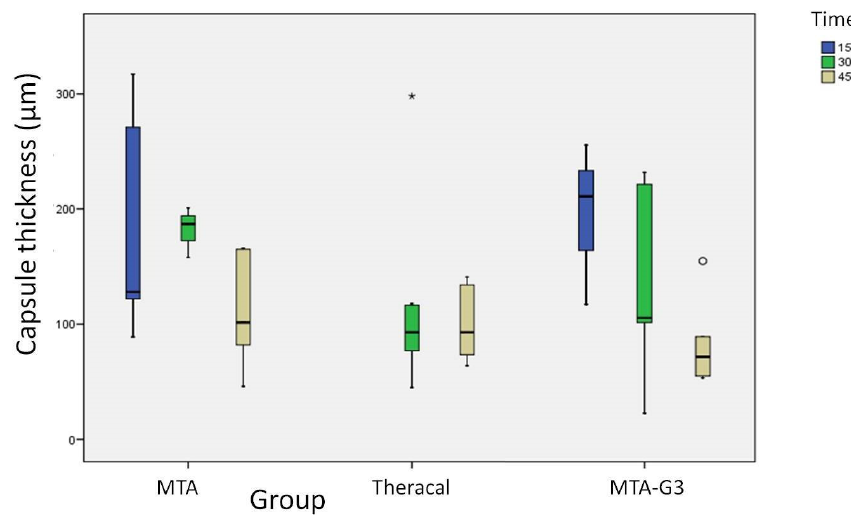
Figure 5. MTA, Theracal and MTA-G3 fibrous capsule thickness. Differences between periods.